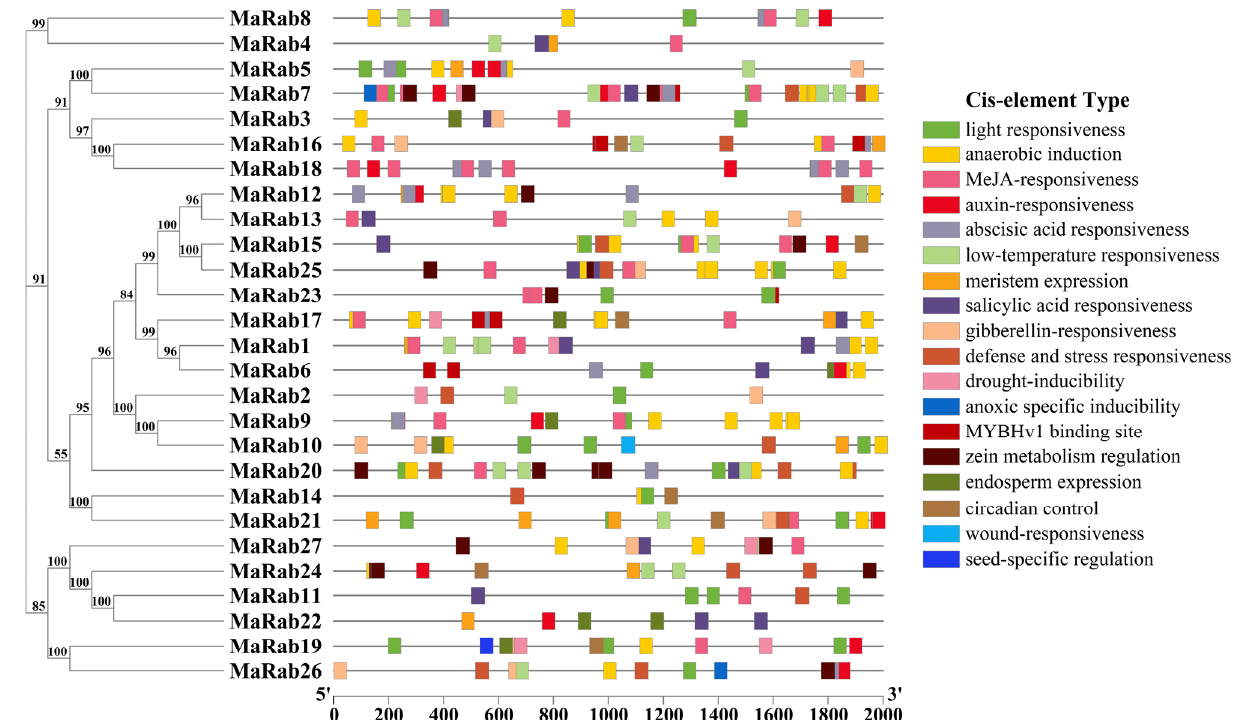
Figure 4. The cis -acting elements ( − 2000 bp) of 27 MaRab genes in M. albus . Different colored boxes represent different types of cis -acting element types. A scale of promoter length is shown at the bottom. The number on the branch indicates the degree of reliability of this branch.